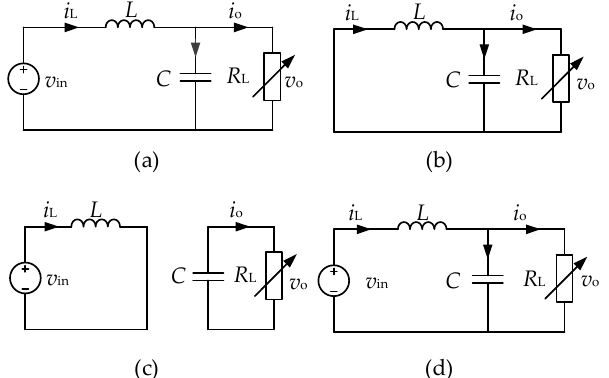
Figure 3. Switching modes of double-switch buck-boost converter. ( a ) Buck mode, S 1 ON and S 2 OFF